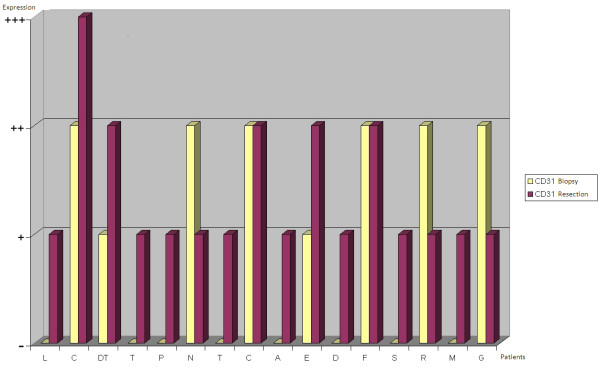
Changes in CD31 expression after neoadjuvant chemotherapy are compared for each patient.